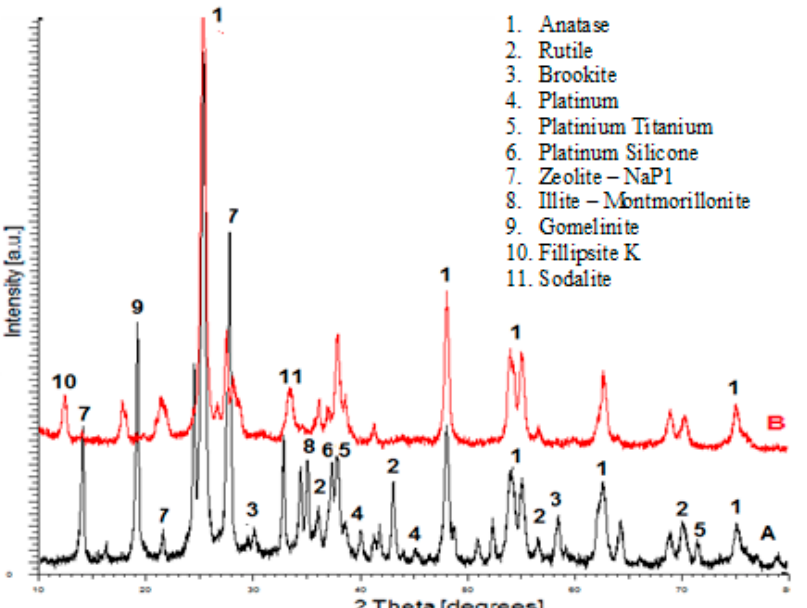
Figure 3. XRD patterns. ( A ) (black line): before adsorption/photocatalysis; ( B ) (red line): after adsorption/photocatalysis.